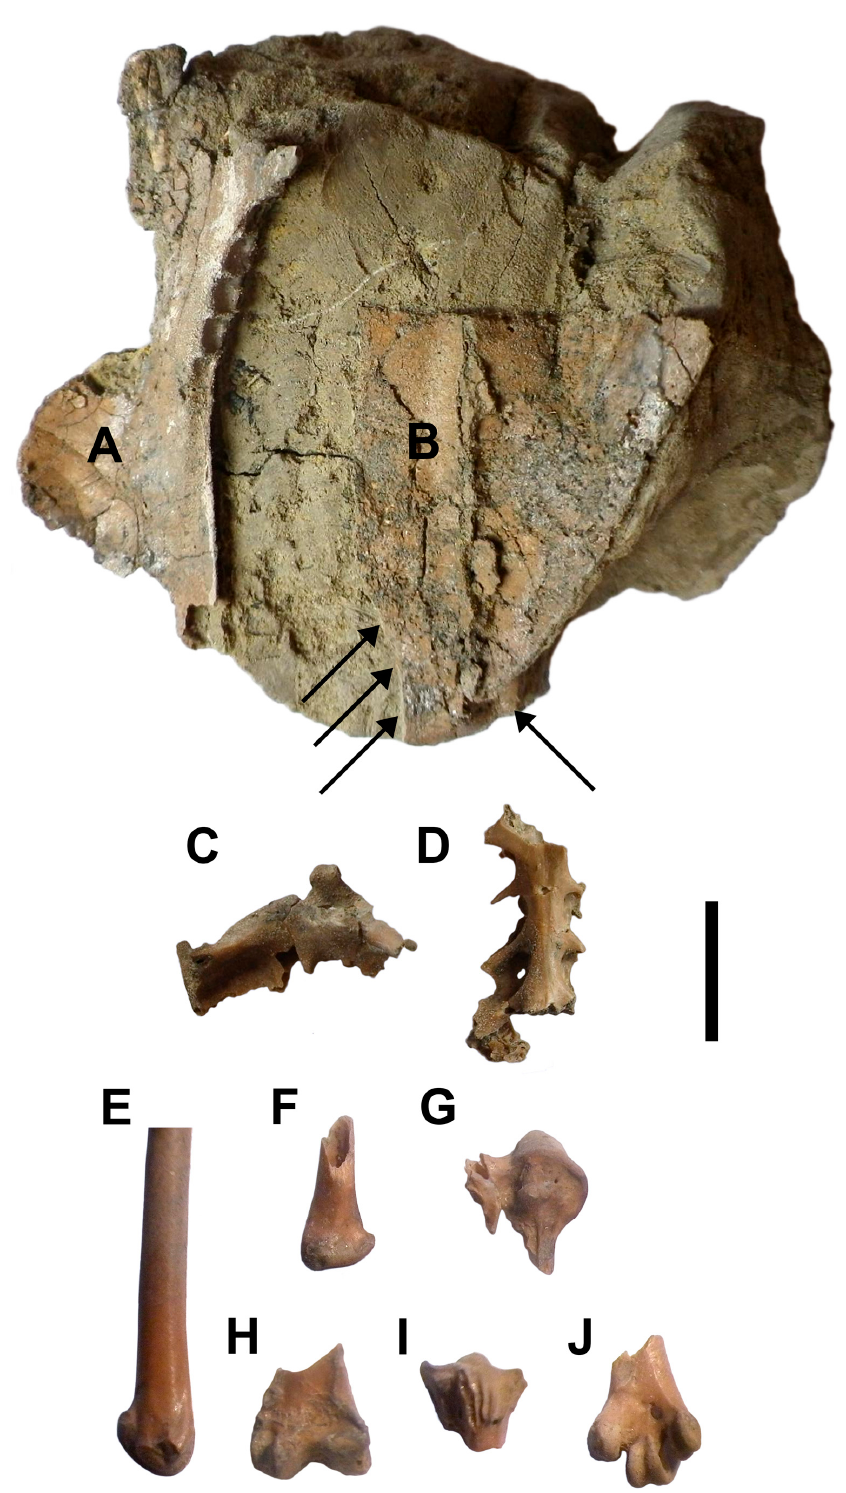
Figure 8. Screamer-like anseriform from the London Clay Formation (NMS.Z.2021.40.3 Anseriformes familia incertae sedis): sternum in matrix, right costal margin and lateral cardiac plate, dorsal aspect ( A ), right ventrolateral aspect, union of right medial abdominal plate and caudal carina marked by label ( B ), arrows denote lateral margins of median trabecula of sternum, cranial extremity, dorsal ( C ); caudal fragment of synsacrum, ventral ( D ); distal left ulna, ventral ( E ); distal right radius, caudal ( F ); proximal right carpometacarpus, ventral ( G ); distal left femur, caudal ( H ); right tarsometatarsus, proximal caudal ( I ), distal caudal ( J ). Scale bar 1